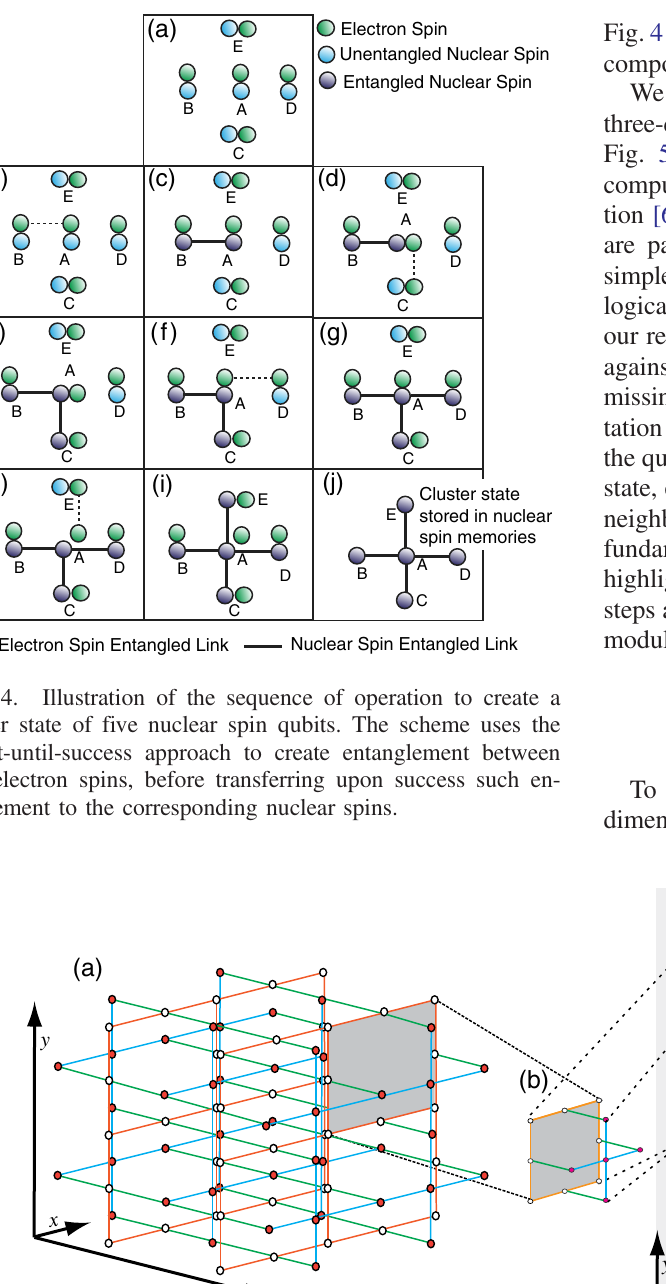
Fig. 4 the sequence of operations for creating a cross cluster composed of five nuclear spins.